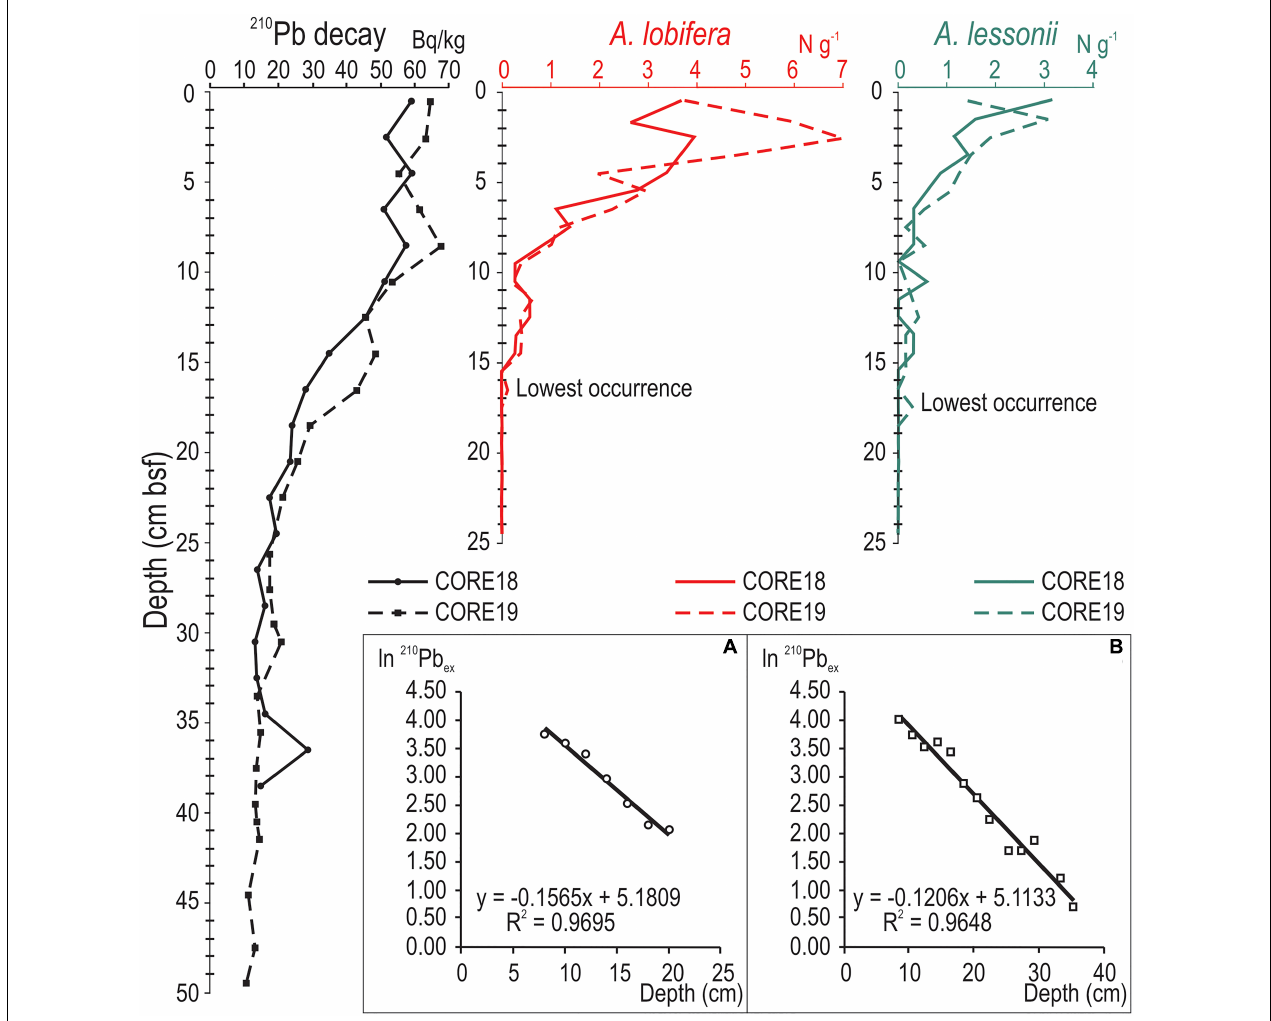
FIGURE 4 | Curves reporting from left to right: 210 Pb decay, showing the typical activity profile decreasing with depth, and absolute abundances of A. lobifera (in red) and A. lessonii (in green) recorded in both cores with a characteristic decreasing trend moving down core. The boxes on the bottom report a constant SAR, respectively of 0.20 cm yr − 1 for CORE18 (A) and 0.22 cm yr − 1 for CORE19 (B) ; this last value was utilized in the applied age model, which leads to an estimated time interval of about 4.5 years for each cm of sediment (see the text for further